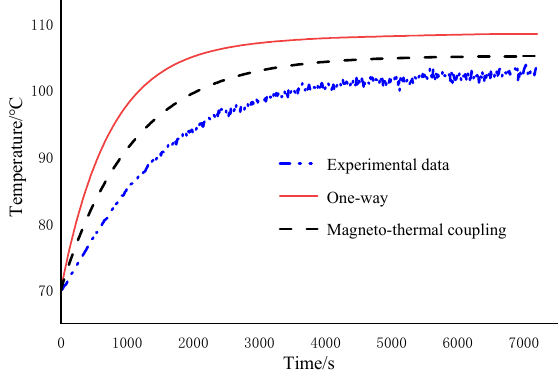
Figure 14. Temperature rise data comparison.